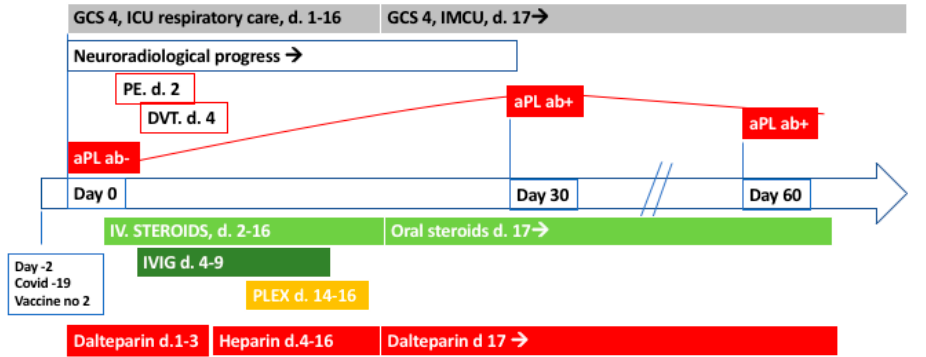
Figure 1. Schematic illustration of the clinical course and management of the patient. GCS; Glasgow coma scale, ICU; intensive care unit, IMCU: intermediate care unit, PE; pulmonary embolism, DVT; deep vein thrombosis, aPL ab; antiphospholipid antibodies, d.; day. IVIG = intravenous immunoglobulin therapy, PLEX; plasma exchange therapy.